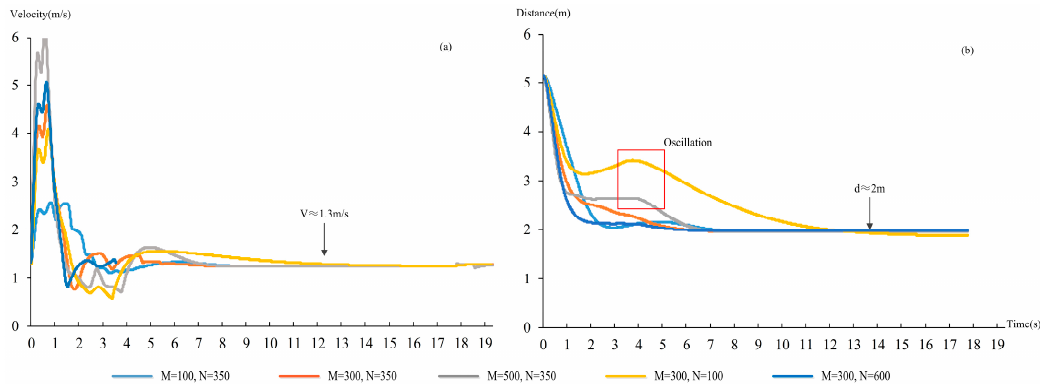
Figure 10. Average velocity of pedestrians and distance of subgroups with different M and N. ( a ) Pedestrians in the rear subgroup adjust their velocities to catch up with the front subgroup and then maintain their speed at 1.3 m/s. ( b ) The time to reduce the distance between subgroups to 2 m.